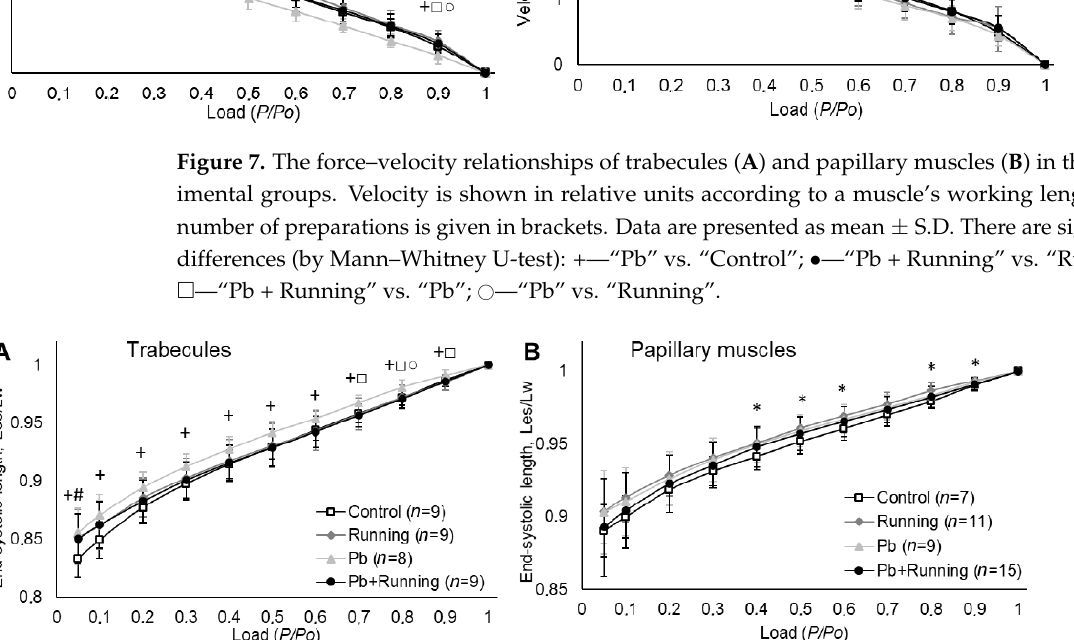
Figure 8. The end-systolic length–afterload relationships of trabecules ( A ) and papillary muscles ( B ) in the experimental groups. The number of preparations is given in brackets. Data are presented as mean ±